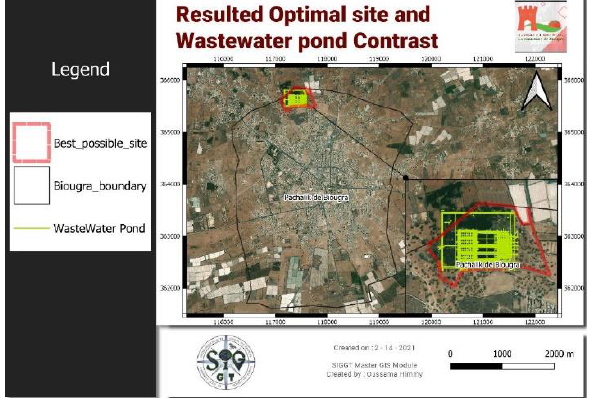
Figure 7 . The map shows the match between resulted site and the existing wastewater pond